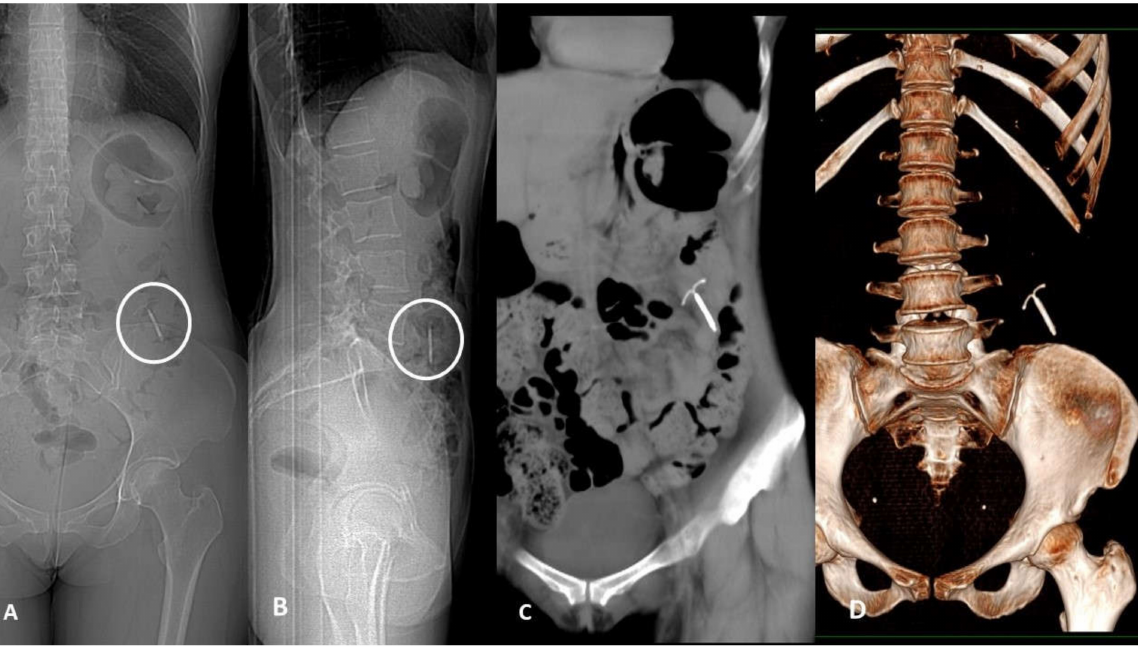
Figure 3. Device migration. Thirty-nine-year-old woman with acute left flank pain and history of copper Intra-uterine device (IUD) insertion 2 years earlier. Frontal ( A ) and lateral ( B ) CT scout of abdomen identify the IUD in the left lower quadrant. Non-enhanced CT scan coronal plane MIP-reformatted ( C ) shows device dislocation medially to descending colon in the pericolic fatty tissue; no displacement-related complications such as pneumoperitoneum or fluid collection were found. CT 3D-reconstruction ( D